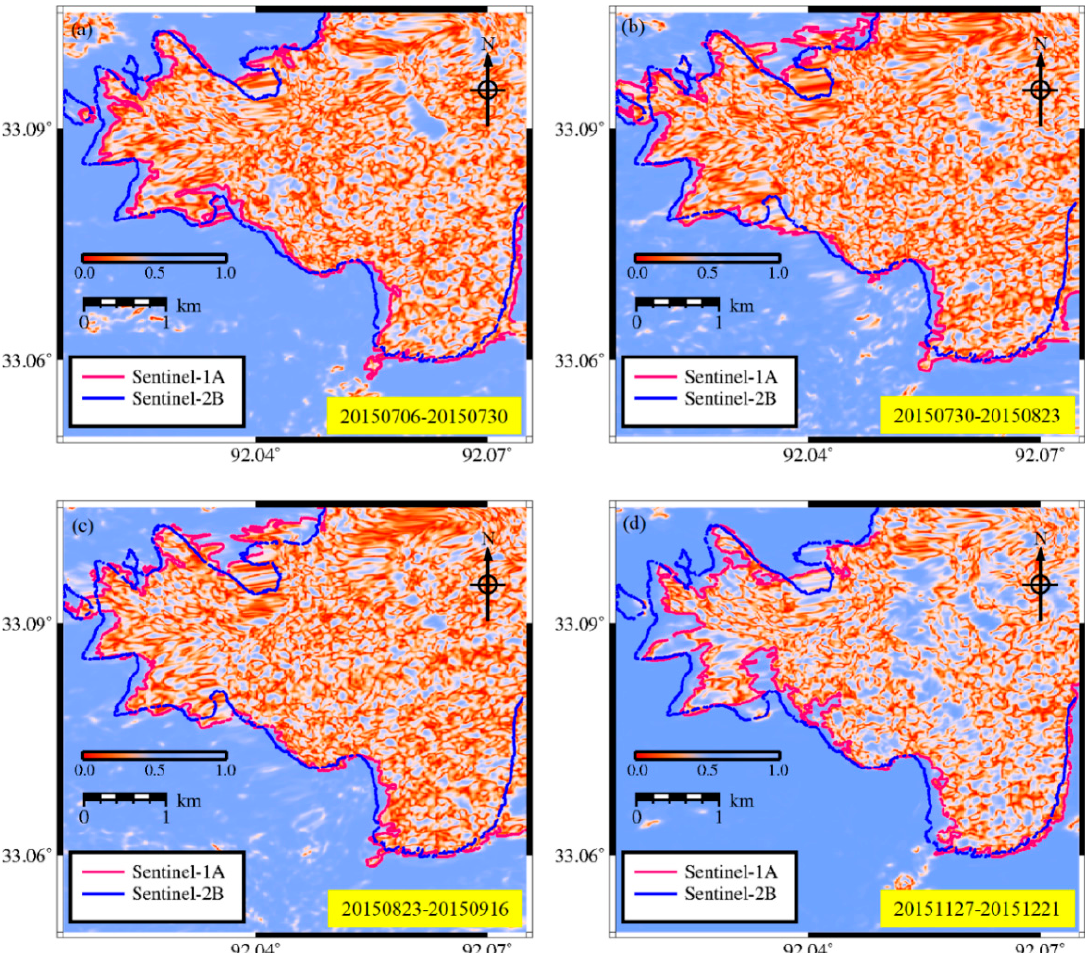
Figure 10. ( a – d ) show the four maps of the DDG boundaries (solid red curves) extracted using the Sentinel-1A coherence maps spanning between July and September (i.e., in the glacier ablation period) and around December in 2015. The DDG boundaries (solid blue curves) derived from the Sentinel-2B optical image are superimposed for a visual check.